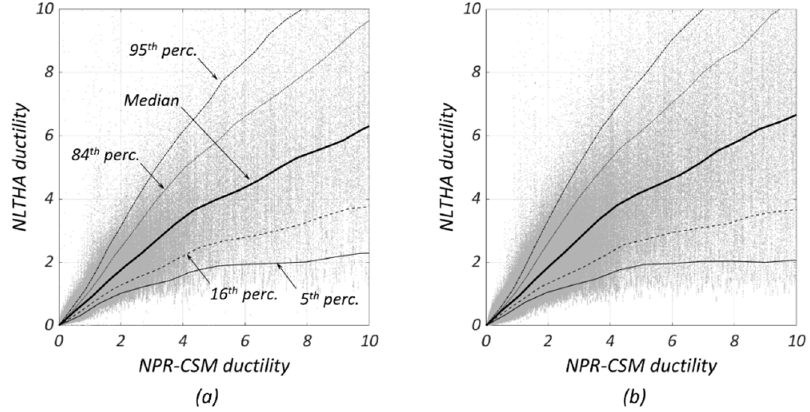
Figure 3. Comparison between ductility demands from the capacity spectrum method (CSM) by NPR 9998-18 and from NLTHA: ( a ) Suite 1-A, and ( b ) Suite 1-B. Figure 4 compares the median C R − R − T and µ R − R − T spectra calculated with the CSM by NPR 9998-18 [18] (solid lines) with those derived from NLTHA (dashed lines) for analysis Suite 2-A. The curves are limited to periods T between 0.1 and 0.5 s and strength ratios R between 1.0 and 5.0. One can observe that, generally, the inelastic displacement ratios C R from NLTHA tend to infinity as T approaches zero, and approximate 1.0 as T goes to infinity. Consistently, the ductility demand µ R from NLTHA approaches the R factor for long periods according to Equation (4).